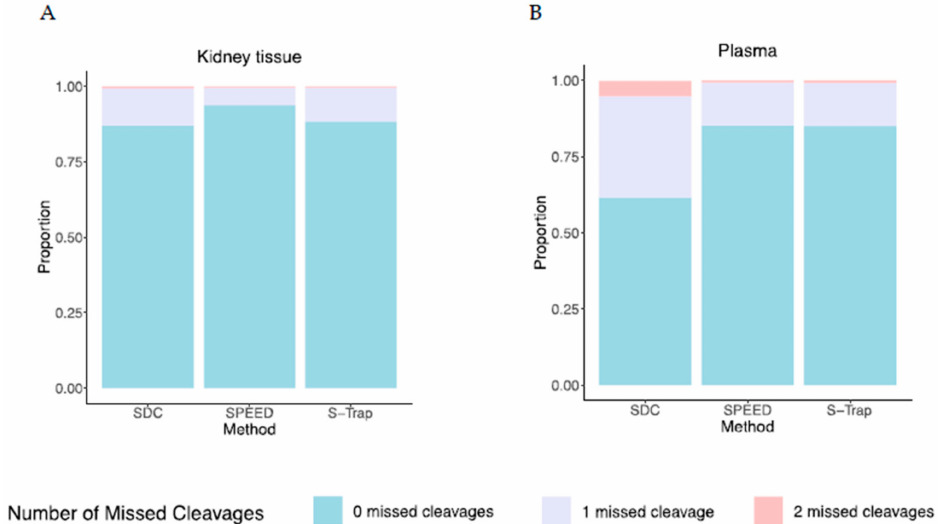
Figure 4. Trypsinization efficiency across preparation methods. The proportion of total detected peptides with missed cleavages for samples prepared using the SDC, SPEED, and S-Trap methods in ( A ) kidney cortical tissue and ( B ) plasma. Proportions displayed are the mean across three biological